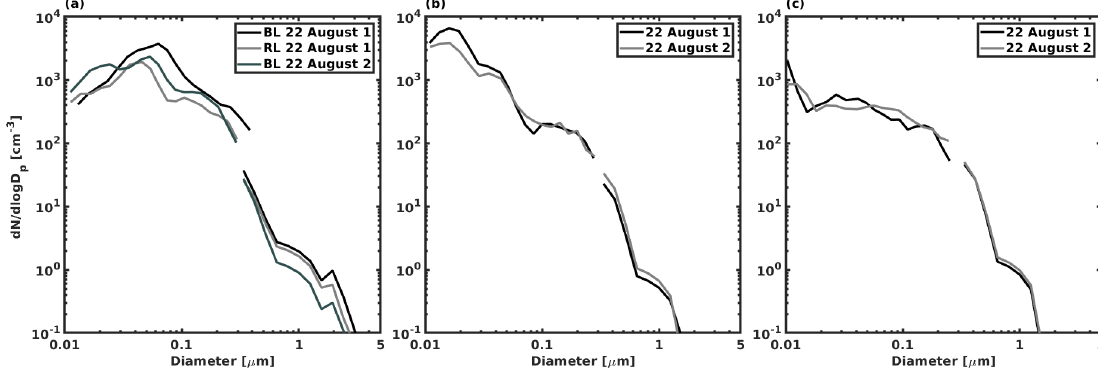
Figure 9. Evolution of the mean aerosol size distribution in Case II for (a) boundary layer, (b) first middle layer, and (c) second middle